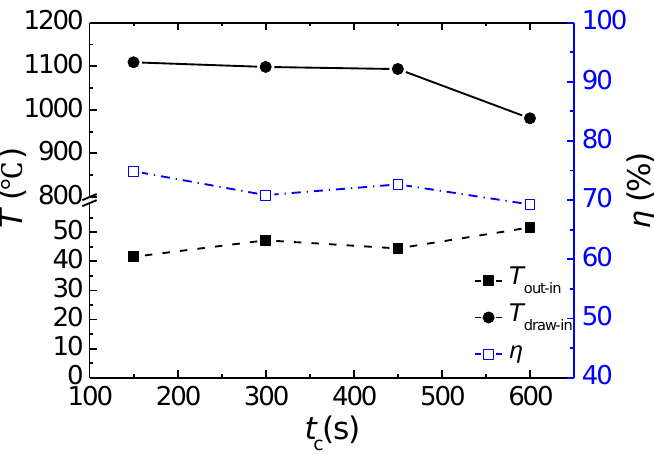
Figure 15. Temperature difference between the hot gas withdrawal flow and inlet gas ( T draw-in ), outlet-inlet gas temperature difference ( T out-in ), and heat recovery efficiency ( η ) for different cycle times ( t c ) at F in ≈ 105 × 10 3 Nm 3 /h and Y CH4,in = 0.95 vol %.